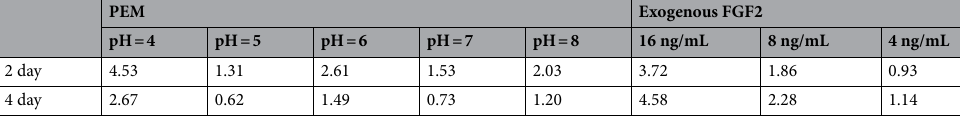
Table 2. Modeled growth factor concentrations after 2 days and 4 days of culture time. For the exogenous FGF2 conditions, values were taken before additional FGF2 was